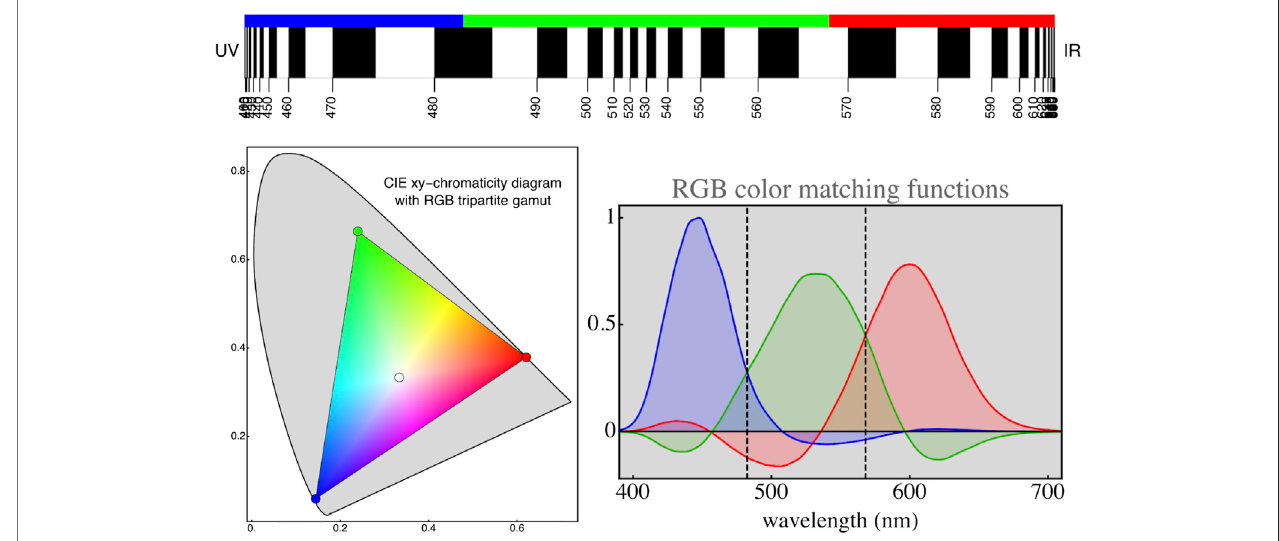
FIGURE5| Top:Therelationbetweenwavelengthsandhue-anglesisverynon-uniform( Figure2 ).Whereaswavelengthrangesfrom0to ∞ ,theangularrangeisa fi nite interval (400 – 700 nm say), the spectral range is really “ limited. ” The red – green – blue tripartition roughly is a fairly even tripartition in the angular domain. The cut loci are 482 and 568 nm, dominant wavelengths 457, 530, and 597 nm, not unlike the so-called (rather vaguely de fi ned) “ unique hues ” (Webster and Miyahara, 2000). Bottom left: The spectrum tripartition de fi nes a gamut in the CIE – xy – chromaticity diagram. This triangular gamut shows the optimum display based on additive mixture of three fi xed radiant sources (We use the CIE diagram here because of its familiarity, not because it is a particularly useful representation.) The colors are a fancy embellishment, they are literally transcribed from the RGB – coordinates as “ pointers ” to qualia. It makes the diagram look like ones encountered on the Internet. Bottom Right:Thecolormatchingfunctionsfortheoptimum tripartition. Thesearejustlinearcombinationsoftheconefundamentals,verysimilartothe “ sharpened ” functionsof Vazquez-Corral et al.